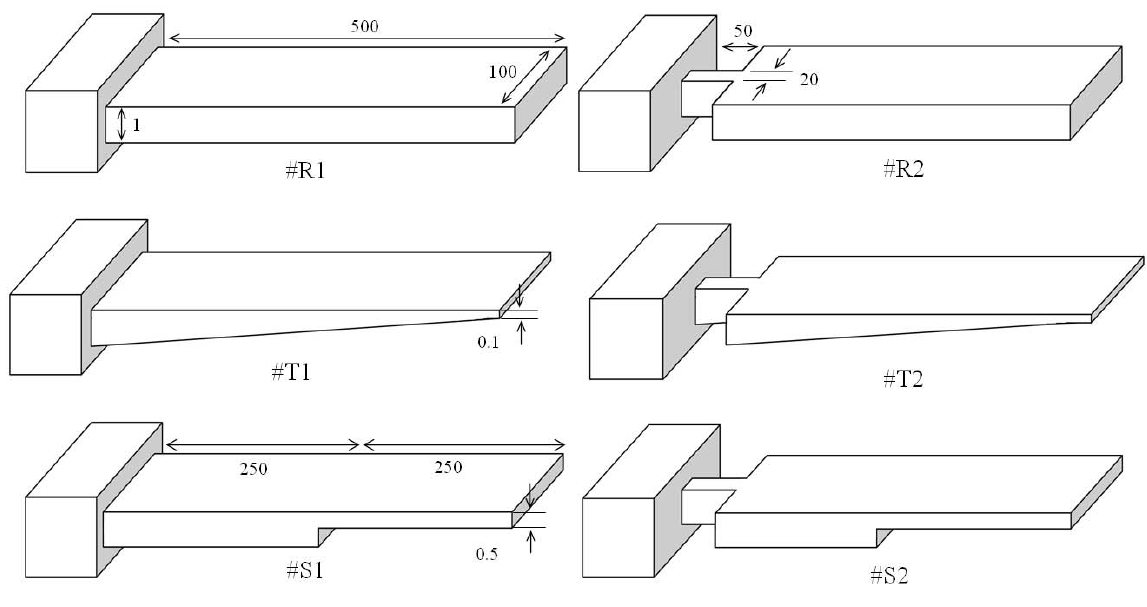
Figure 2. Comparison between basic and modified rectangular (R), triangular (T), and step (S) profile cantilevers. All the models have equal length, width, and fixed-end thickness (unit: